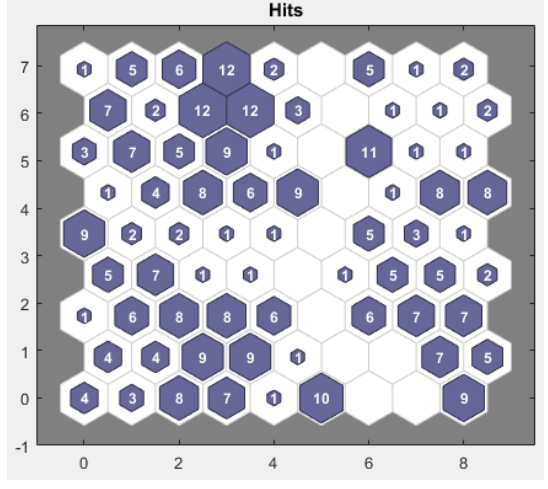
Figure 5. Cluster of neurons